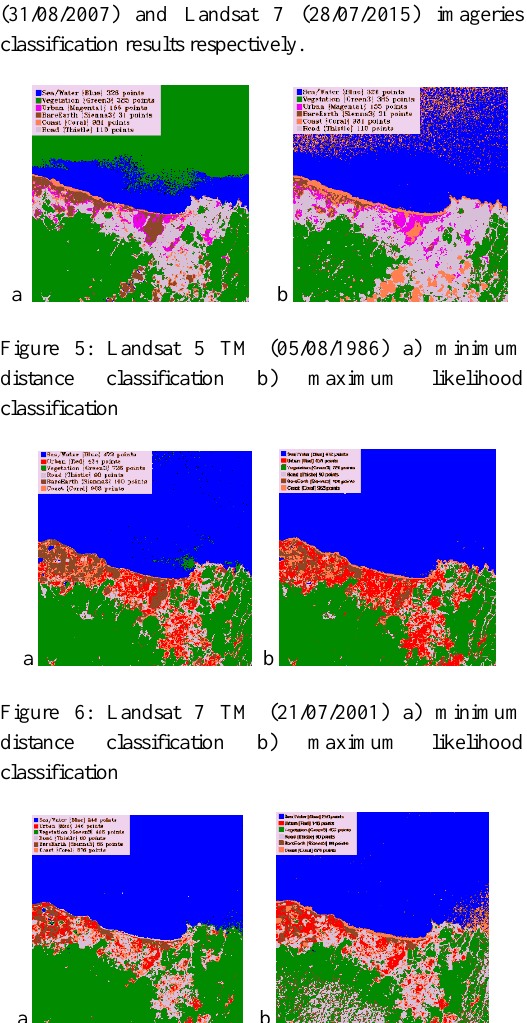
Table 2: All data and their overall accuracy with kappa